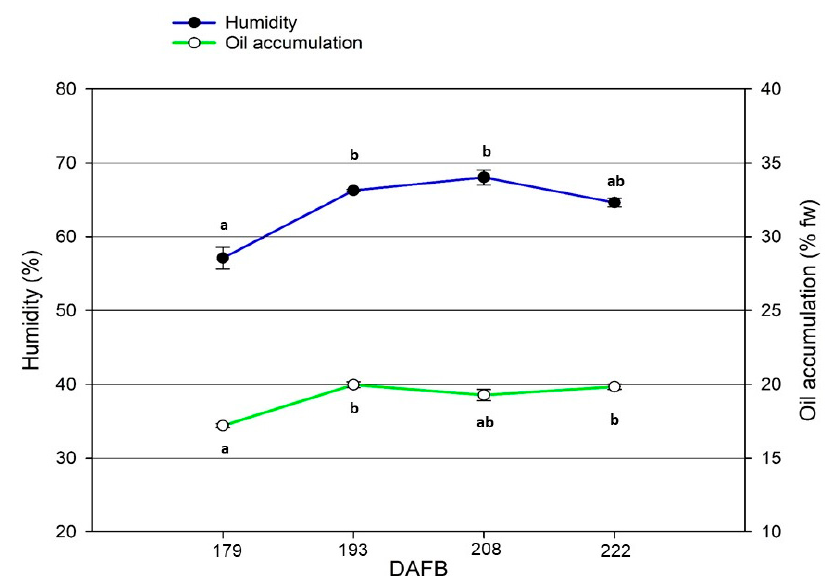
Figure 7. Oil accumulation (% fw) and humidity (%) in olives of ‘Lecciana’ during ripening (DAFB (DAFB = days after full bloom). Mean values of two subsequent seasons ( ± SE ). Lower case letters = days after full bloom). Mean values of two subsequent seasons (± SE ). Lower case letters denote denote statistical differences at p = 0.05 (Siegel-Tukey statistical differences at p = 0.05 (Siegel-Tukey test).